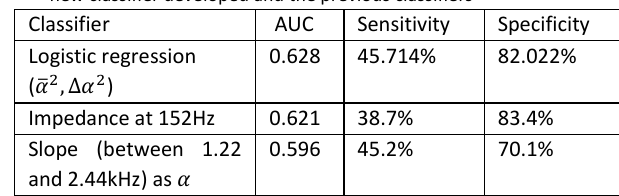
Table.7: Classification performance comparison between